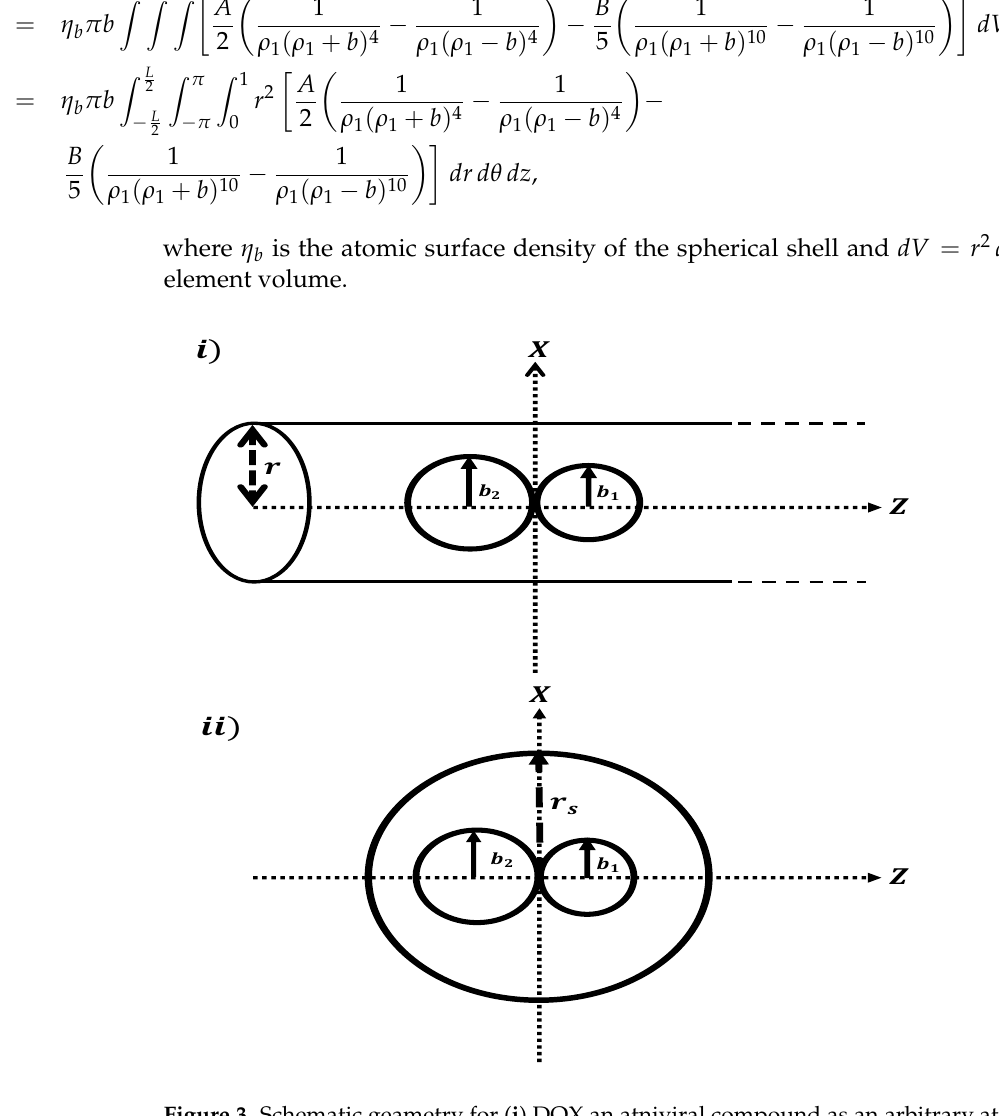
Figure 3. Schematic geametry for ( i ) DOX an atniviral compound as an arbitrary atom interacting with SWCNT of radius r ; and ( ii ) DOX an atniviral compound as an arbitrary atom interacting with fullerne derivatives (C N -(OH) β ) of radius r s